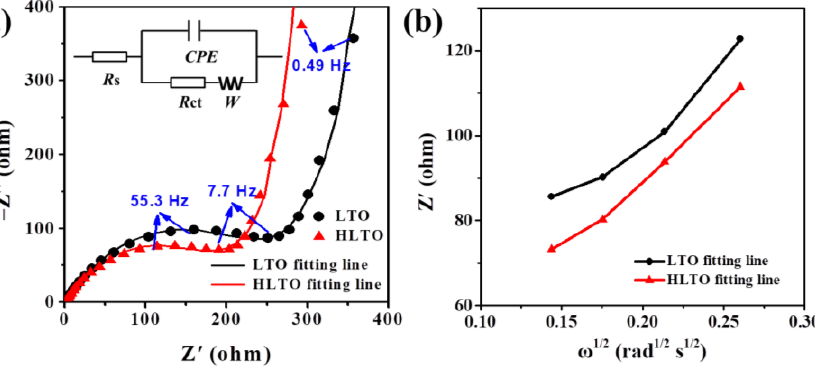
Figure 7. ( a ) EIS spectra of LTO and HLTO electrodes; ( b ) plot curves of Z’ versus ω 1/2 of three LTO electrodes in the low-frequency region. The inset in ( a ) shows the equivalent circuit model. Table 1. Summary of the EIS fitting results of LTO and HLTO.